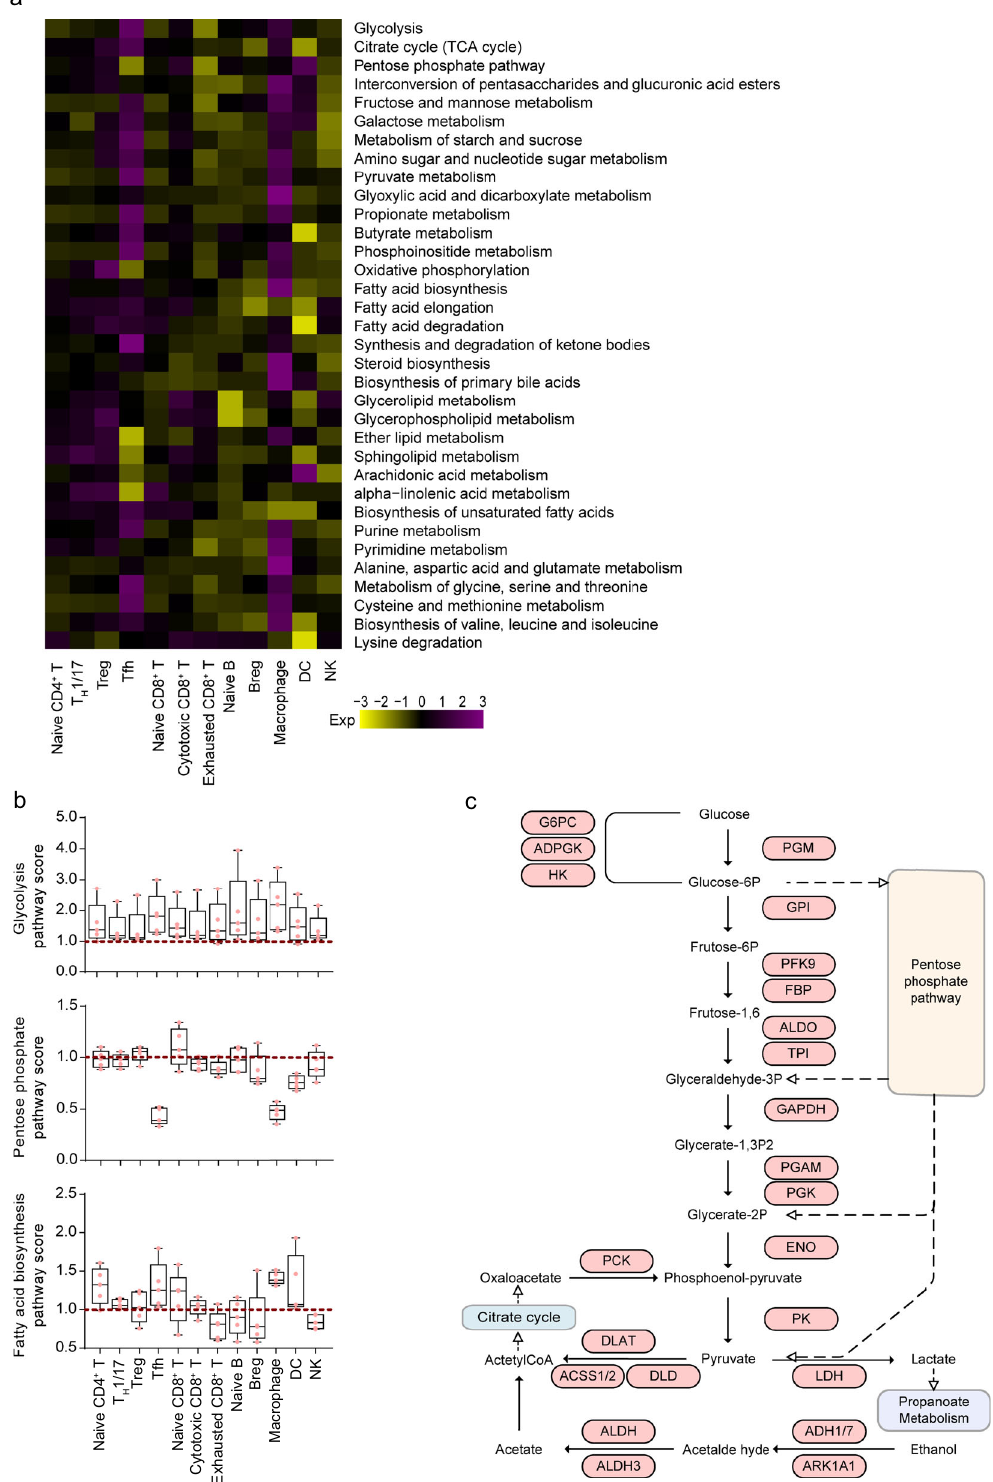
Fig. 5 Metabolic heterogeneity in MPE patients. a Heatmap of the indicated metabolic pathway scores in MPE. The expression value used in the heatmap is the ratio of the average enrichment scores of the corresponding pathway in MPE and blood. b Distributions of the average enrichment score of the indicated metabolic pathways in MPE immune cell subtypes. c Map of glycolysis metabolic pathways of Tfh cells. The genes marked in red are upregulated in MPE vs. blood. n = 5 samples. The box plots were de fi ned by the interquartile range (IQR, the range between the 25% and 75%) and the median, whiskers represent the upper and lower value within 1.5 times the